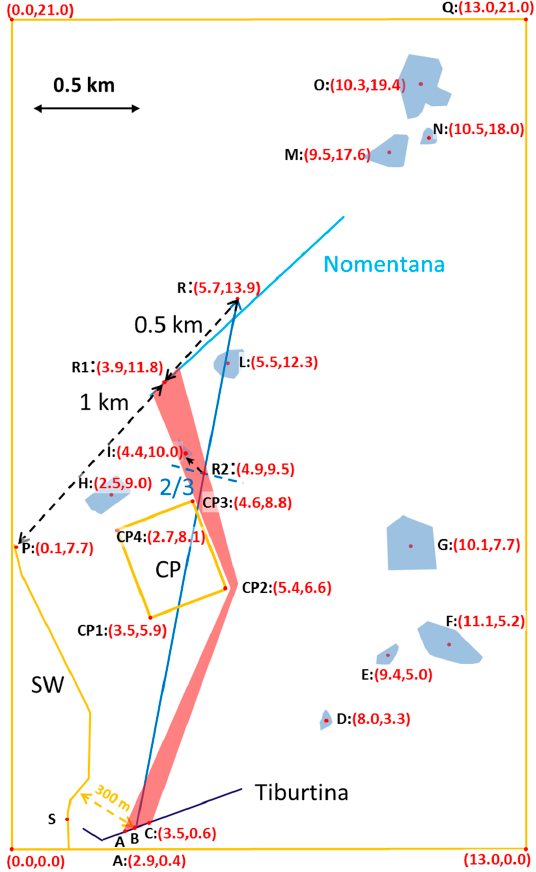
Figure 10. Map of the catacomb area between Via Tiburtina and Via Nomentana with all coordinates of the locations necessary for the Monte Carlo simulation; scale: 5.4 units = 1000 m. Via Tiburtina beginning at Porta Esquilina is traced with the black line joining A ( 2.9, 0.4 ) and C ( 3.5, 0.6 ) . Via Nomentana is traced with a blue line; the point R ( 6.1, 14.0 ) is approximately 1.5 km from Porta Collina, point P ( 0.1, 7.8 ) ; the point R 1 ( 3.9, 11.8 ) is approximately 1.0 km from Porta Collina. Peter’s walk starts at some point of Via Tiburtina, between A ( 2.9, 0.4 ) and C ( 3.5, 0.6 ) . The point CP 2 ( 5.4, 6.6 ) marks the breaking point of Peter’s straight walk. The blue short dashed arrow, set approximately at 2 / 3 of the total path between Via Tiburtina and Via Nomentana, locates Peter’s detour point R 2 ( 4.7, 9.5 ) . “I” stands for the Anonymous Hypogeum. The dark blue area show catacombs’ areas with their barycenter’s